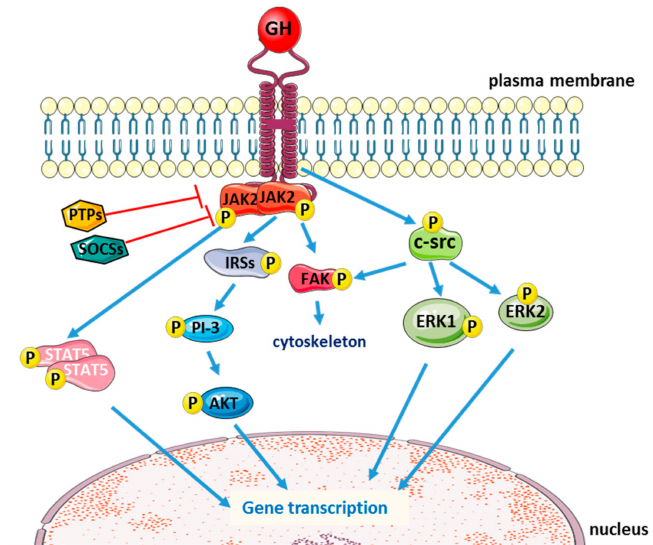
Figure 1. Schematic representation of the main intracellular signaling pathways activated by the binding of growth hormone (GH) to its receptor (blue arrows: activation; red T-arrows: